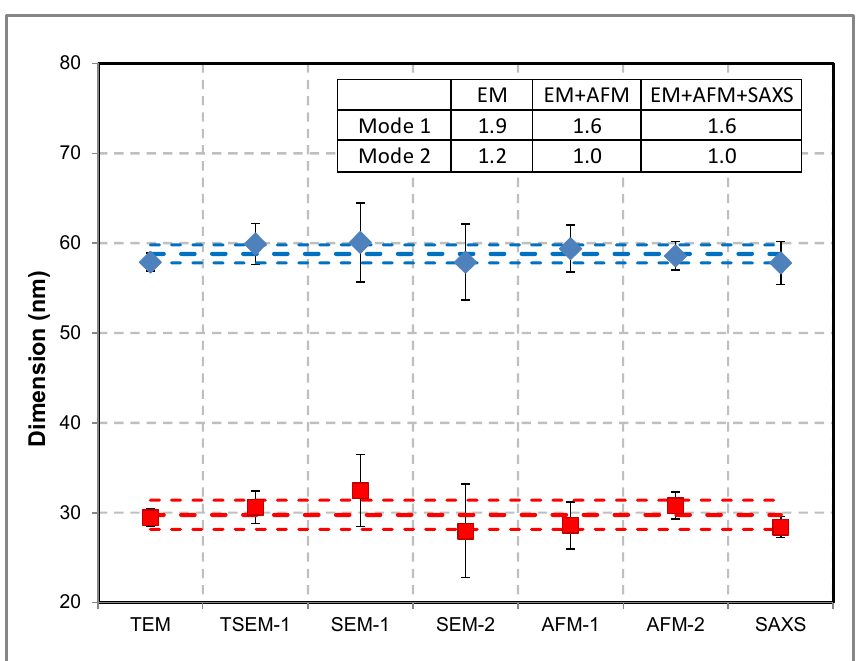
Figure 4. Size measurements of nPSize12 material (bimodal nanosilica) performed with different techniques and by several laboratories. D eq was determined by TEM, TSEM, and SEM, h AFM was determined by AFM, and D SAXS was determined by SAXS. Modes 1 and 2 are represented by red and blue symbols, respectively. The inset table gives the data spread calculated with the standard deviation by taking into account the measurements with EM (electron microscopy), EM + AFM, and EM + AFM + SAXS. The uncertainty bar (k = 2) is not visible when the associated uncertainty is too small. The dotted lines correspond to the mean values associated with standard deviations calculated from the results obtained by all techniques.